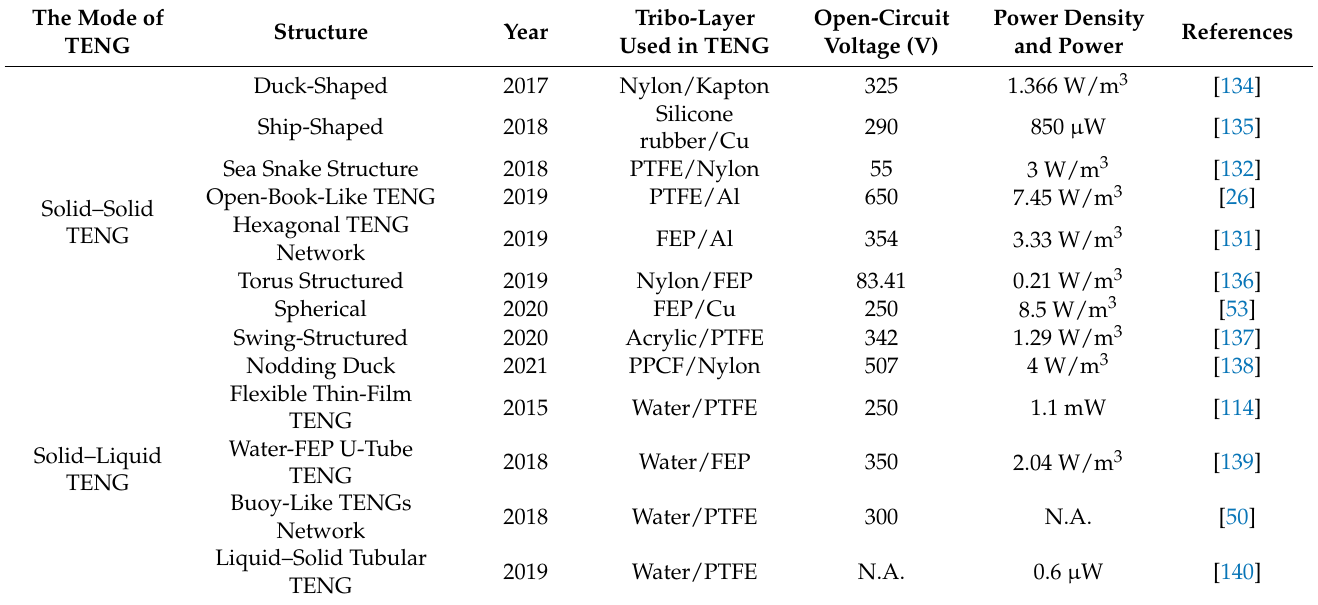
Table 1. Summary of TENGs for water wave energy